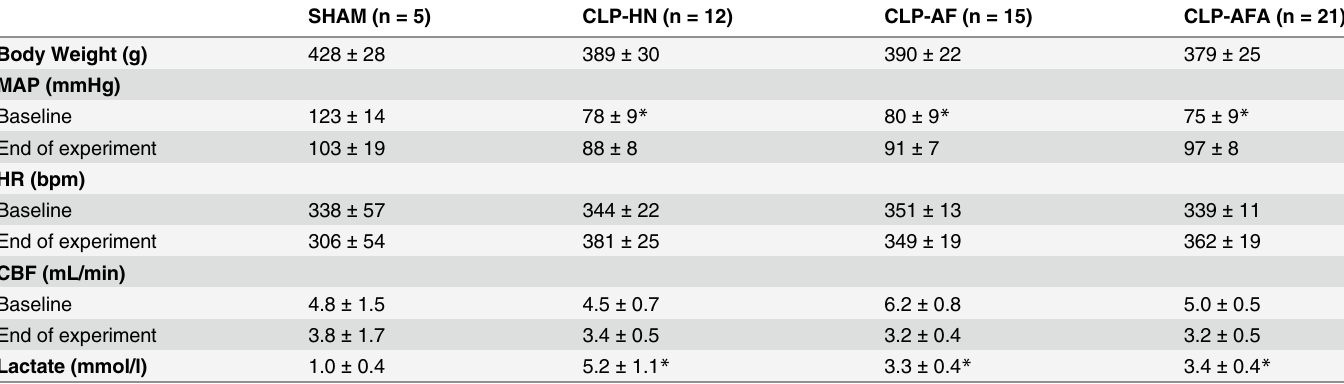
Table 1. Characteristics of septic and control rats: clinical records from the onset of septic shock to the end of the experiment and effects of differ- ent enteral nutrition formulations.